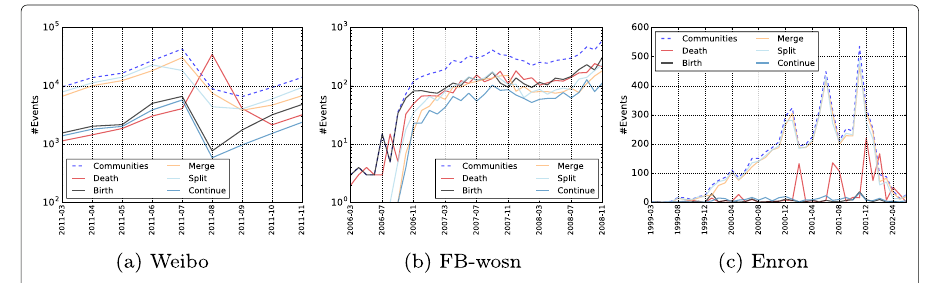
Fig. 6 Event Trends. For each dynamic network are reported the trends (in absolute numbers) of community events. Moreover, the trends of identified communities as time goes by is also